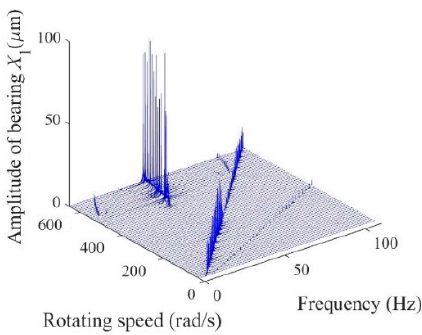
Figure 19. Frequency waterfall chart of the rotating shaft along a vertical direction at oil pressure of 1.2 MPa.